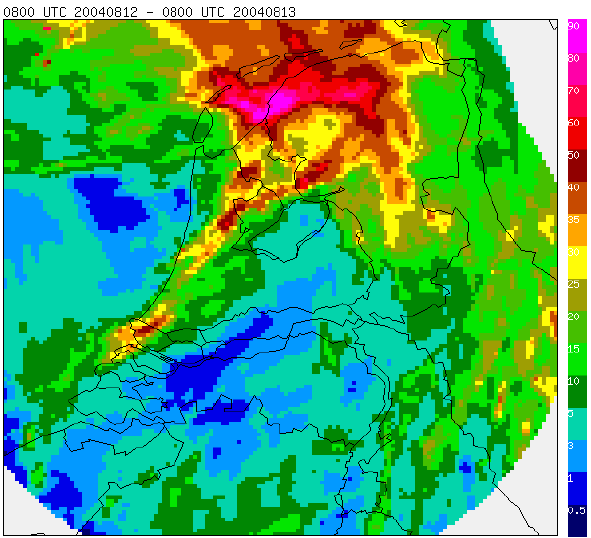
F4 Fig. 4. Radar image of The Netherlands, accumulated precipitation (mm) over the time period between 12 August 2004 08:00 UTC and 13 August 2004 08:00 UTC.